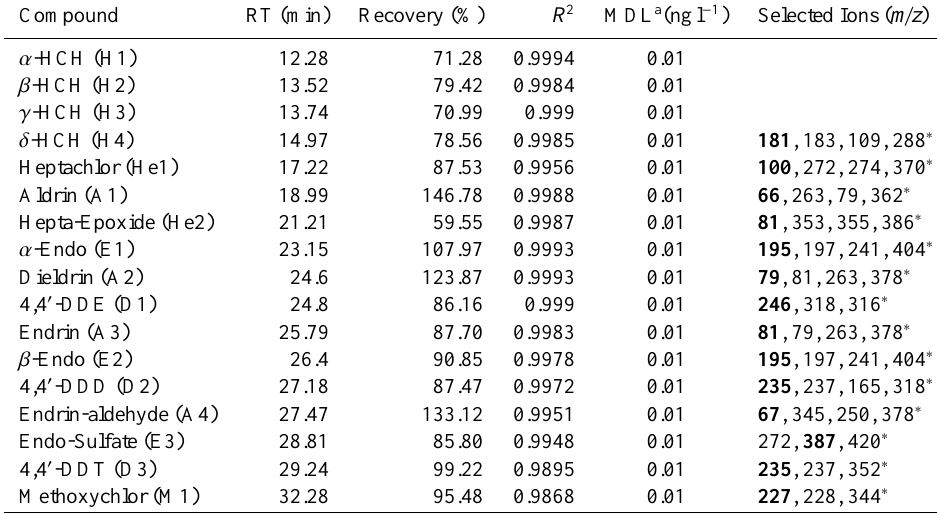
Table 2. Standardisation of OCP’s compounds using GC-ECD and